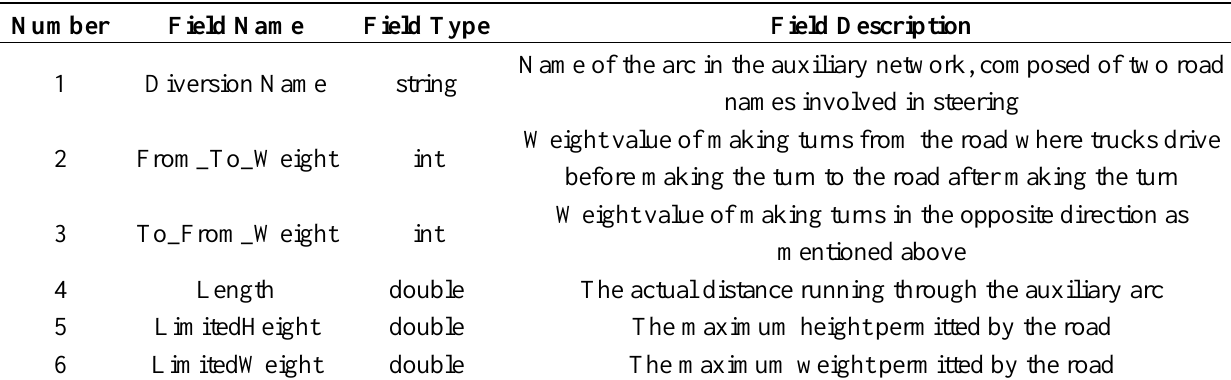
Table1. Storage structure of the auxiliary network based on the